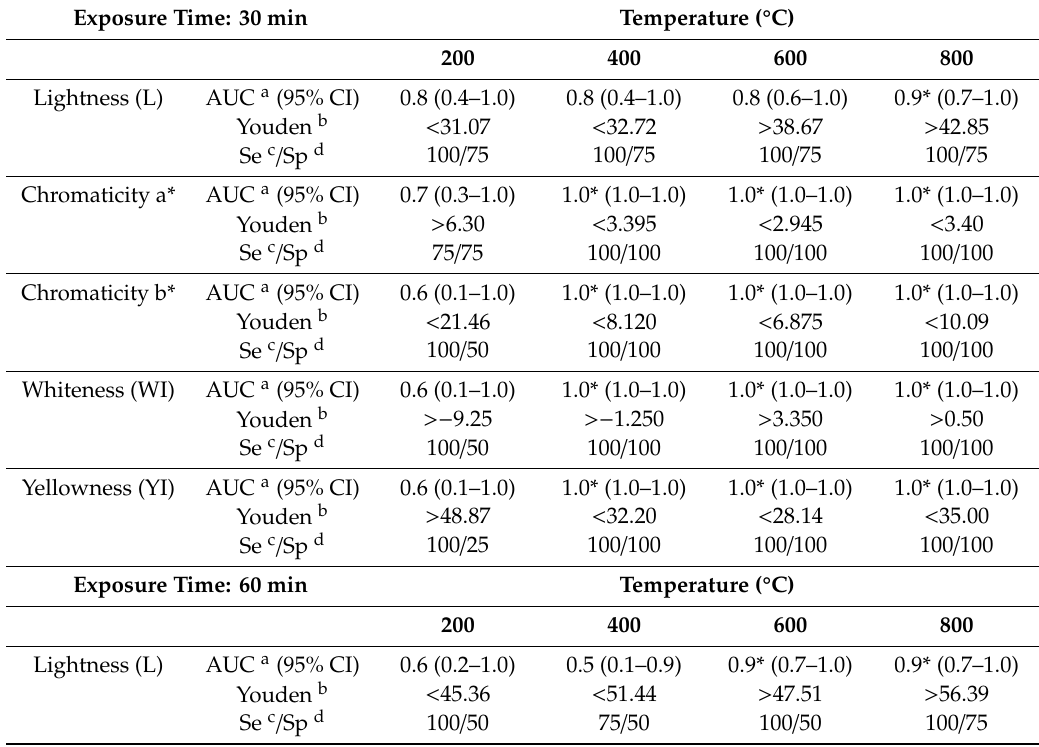
Table 2. Receiver Operating Characteristics (ROC) analysis predicting temperature of burned medullar bone for 30 and 60 min with L, chromaticity a*, and chromaticity b* values and with whiteness (WI) and yellowness (YI)